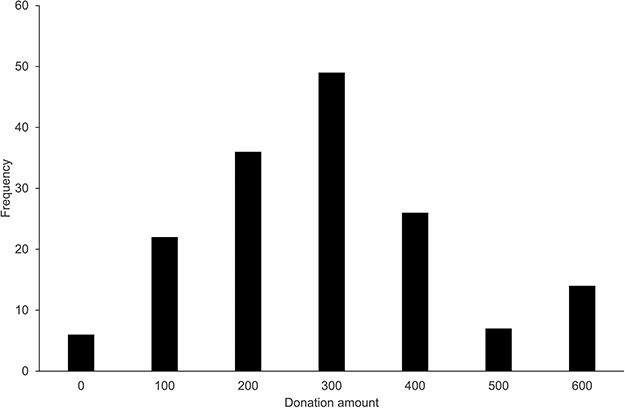
This figure shows the absolute frequencies of prosocial donations made in the one-shot dictator game. Participants could divide 600 valuable tokens by picking one of seven divisions.